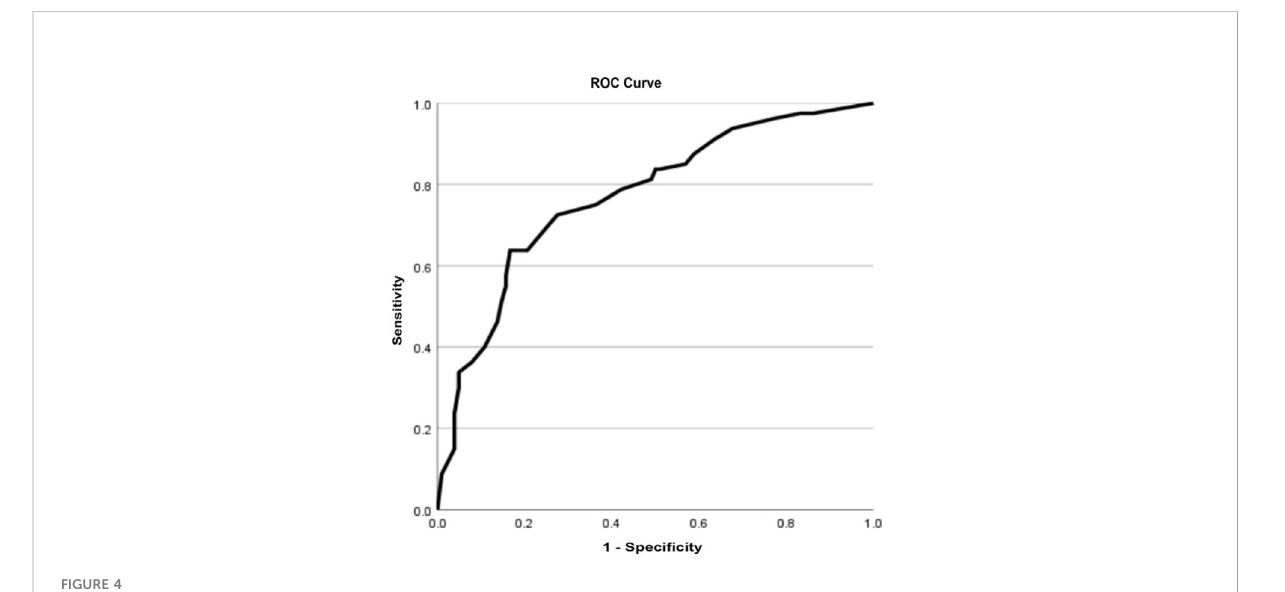
FIGURE 4 The ROC